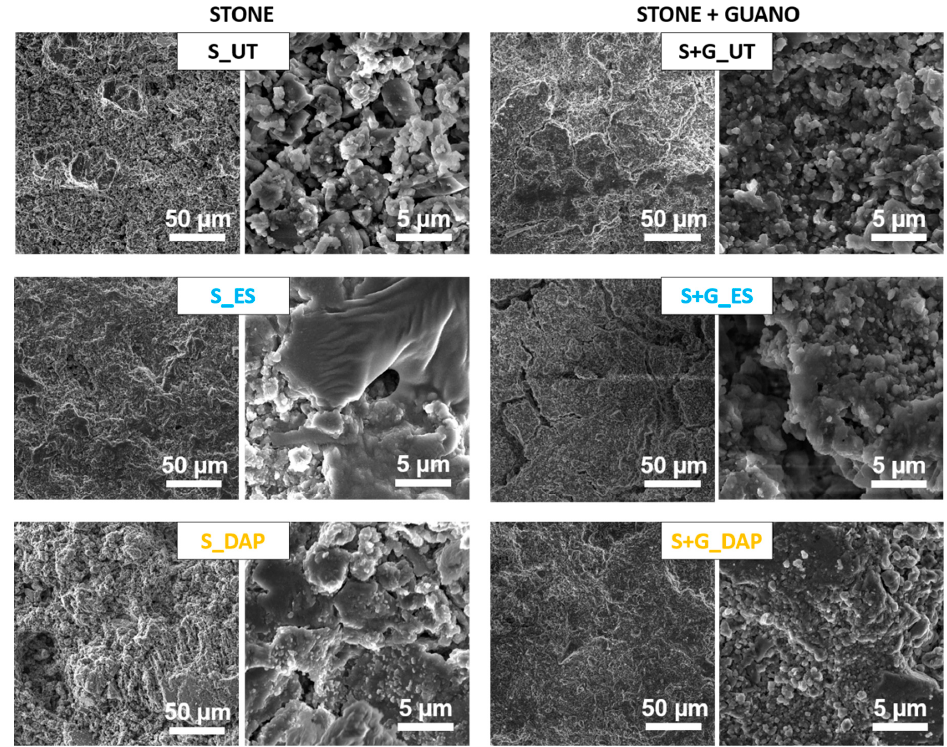
Figure 4. Morphology of untreated and treated stone (“ST”) and stone+guano (ST+G”) specimens.